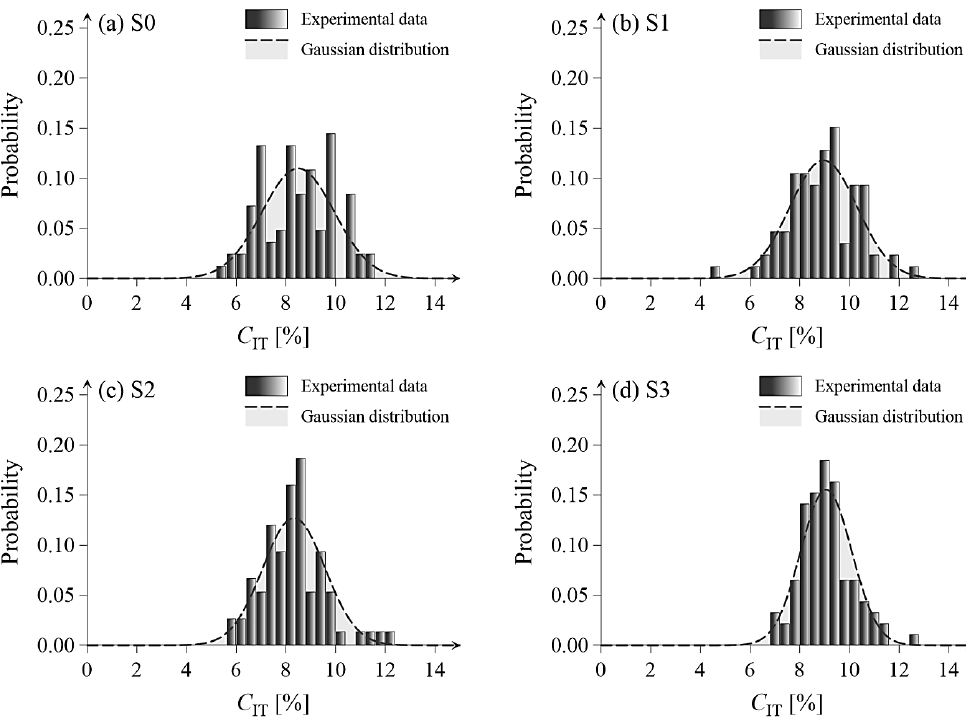
Figure 12. Histograms of the creep coefficient C IT for samples ( a ) S0, ( b ) S1, ( c ) S2, and ( d ) S3.